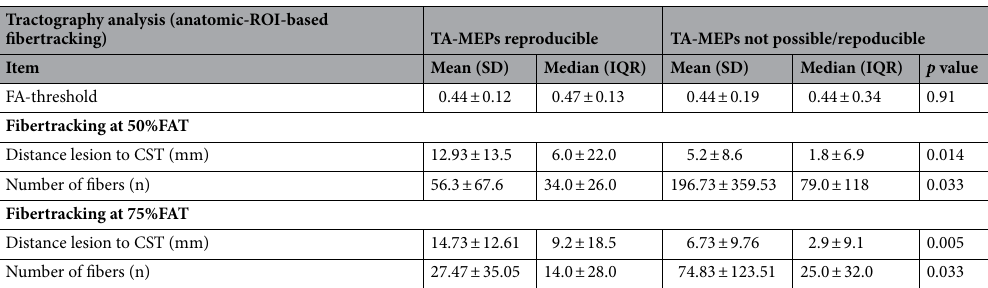
Table 5. Comparison of anatomic based tractography of patients with reproducible MEPs and patients in which mapping of the TA muscle was not possible or reproducible.